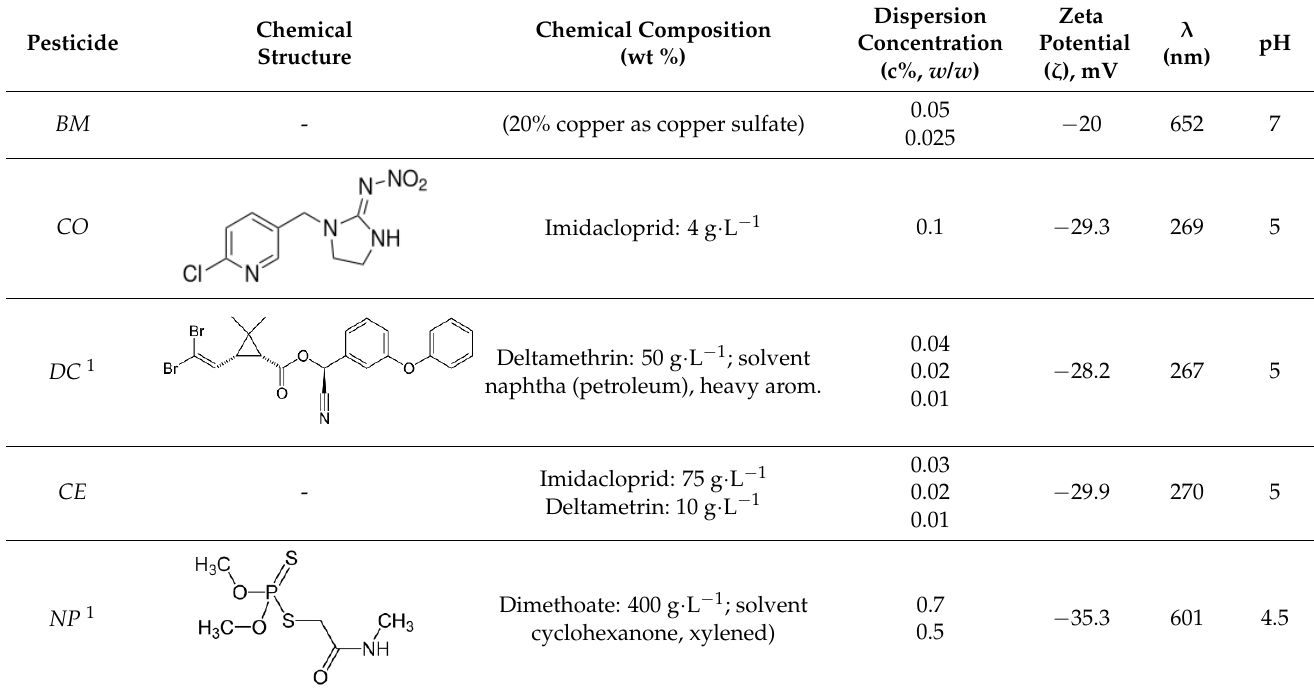
Table 2. Pesticides and dispersions characteristics.